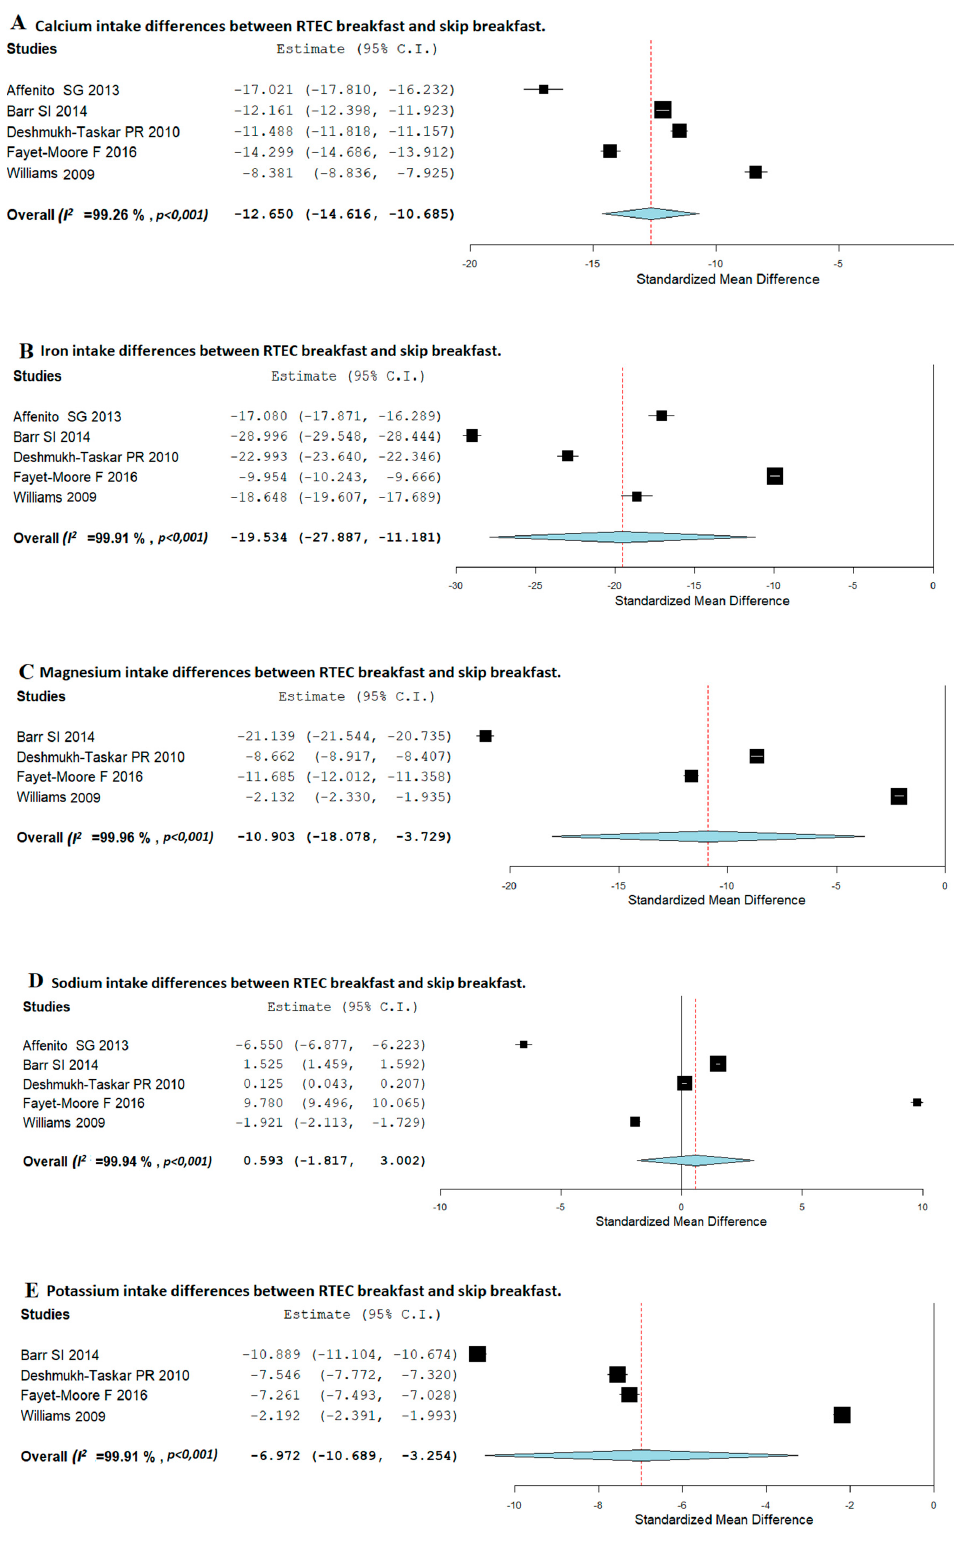
Figure 3. Random-e ff ects meta-analysis of the e ff ects of relationships between RTEC breakfast and breakfast-skipping concerning calcium ( A ), iron ( B ), magnesium ( C ), sodium ( D ), and potassium ( E )